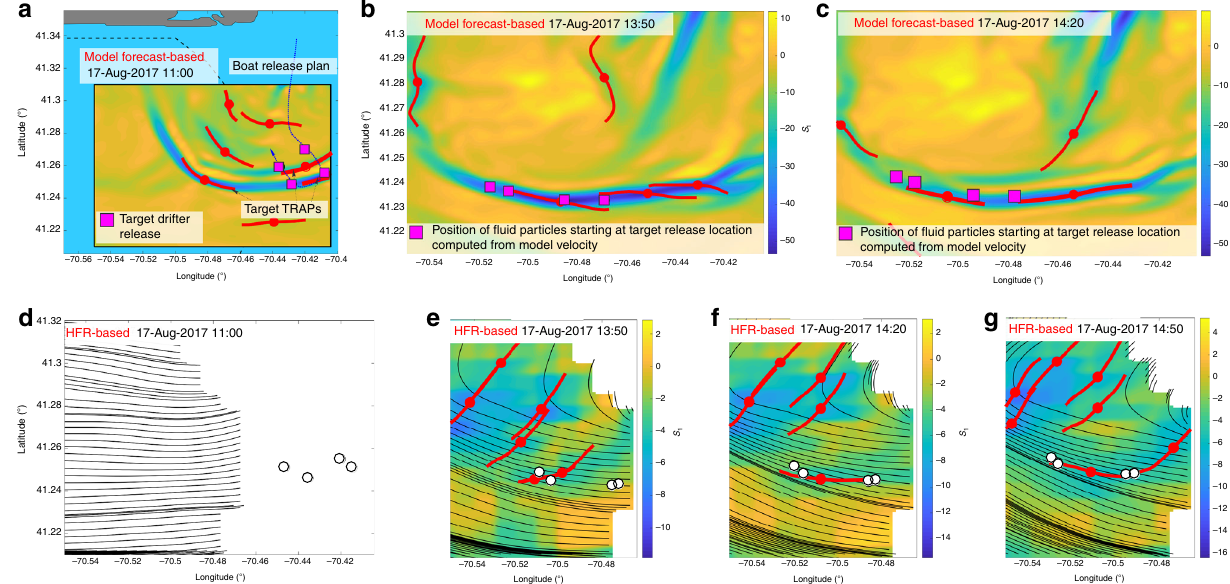
Fig. 5 2017 experiment. a Drifter release plan on the 17th of August 2017 based on the 24h forecast model fl ow velocity provided on the 16th at 7 pm. Magenta squares denote the target drifter release location at 11:00 am (EDT). b and c TRAPs from model velocity at later times in the focus region bounded by the black rectangle in a . Magenta squares are the current position of fl uid particles starting at the drifters release location, and computed by integrating the model fl uid velocity. d Deployed drifters based on a – c along with HFR-based TRAPs. GPS-tracked drifters position (white dots) at 11:00 am along with the fl ow streamlines computed from the HFR velocity fi eld. The domain corresponds to the focus region in the panels above. e – g Drifter positions a few hours later, along with the corresponding TRAPs and streamlines computed from the HFR velocity fi eld. The unit of s 1 is day − 1 .